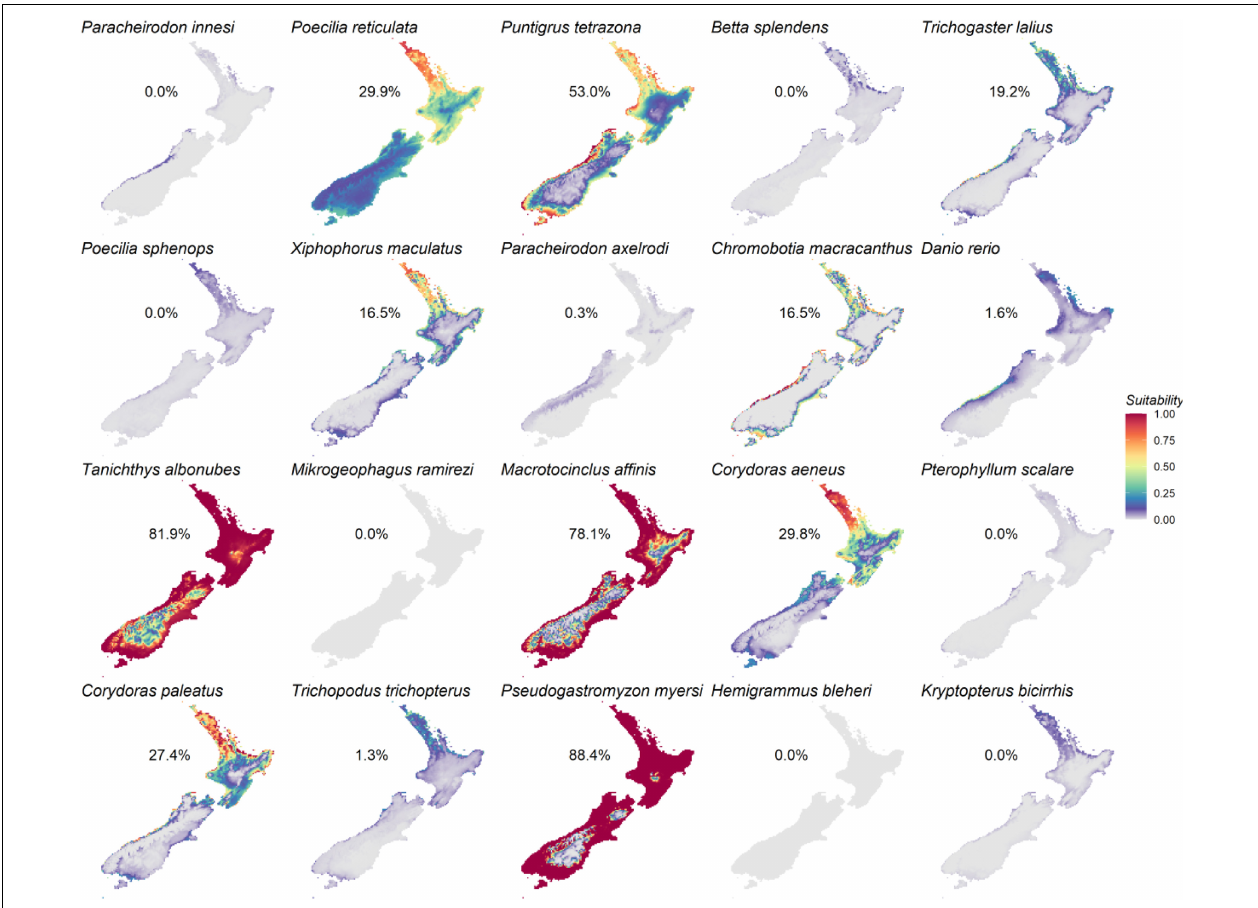
FIGURE 5 | Heat maps of New Zealand’s habitat suitability for the 20 prioritized aquatic ornamental species imported to New Zealand as predicted by the species distribution models. Suitable habitat, based on the 10th percentile training presence threshold, is shown for each species as a percentage of the surface area of New